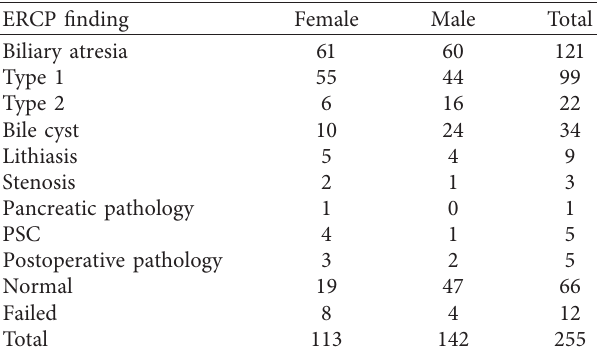
Figure 2: Todani classification of biliary cysts. Table 1: ERCP findings: types and frequency.